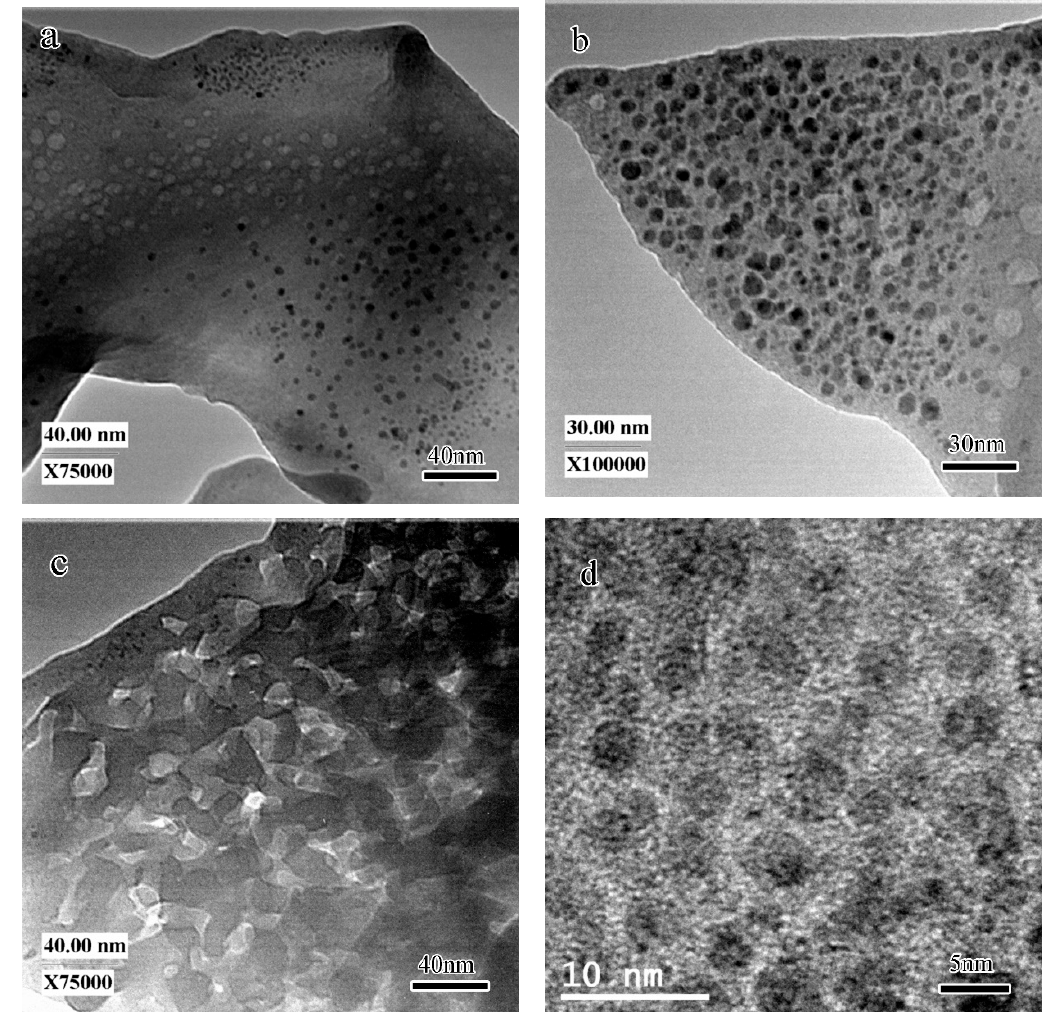
Figure 4. TEM images of the unheated GP: ( a ) the typical morphology of the amorphous hydration products (area A), nano crystals (area B) and nano pores (area C); ( b ) the agglomeration of the nano crystals; ( c ) the high-magnification image of the nano pores; ( d ) the high-magnification image of the nano crystals.